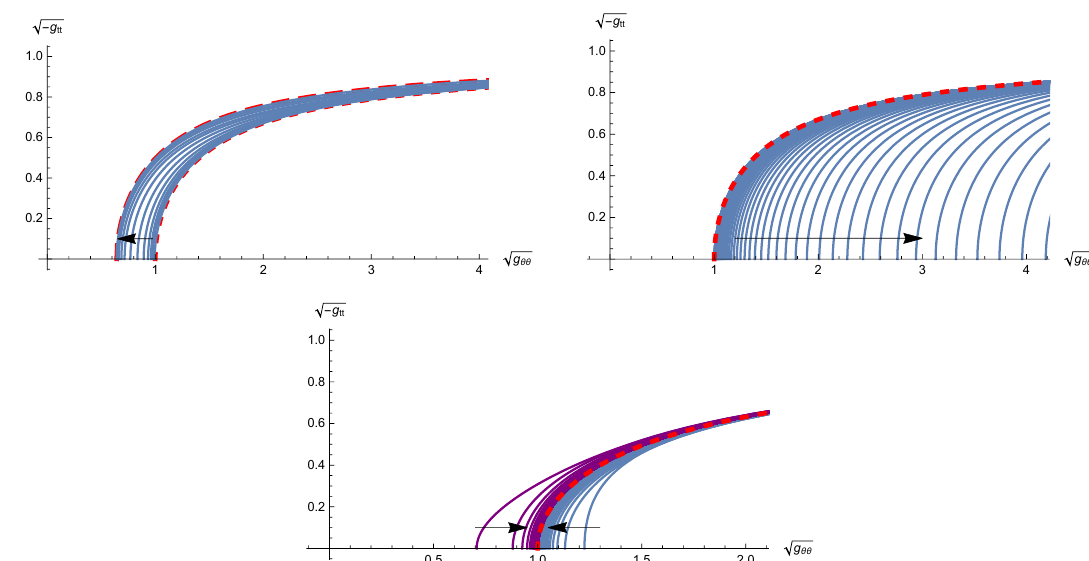
√ √ Figure 7 . Figure showing curves of − g tt against g θθ at constant intervals now for the magnetic EM flow. The top left and right hand frames are similar to those of the previous figure, being for an unstable magnetic RN solution with r − = 0 . 2 perturbed initially to have smaller horizon size (left) or larger horizon size (right). The latter gives the same expanding horizon behaviour as that of the uncharged or electric cases — here ∆ λ = 0 . 5 . The red dashed curve again shows the geometry of the initial RN fixed point that is perturbed. In the initially contracting case here a new stable magnetic RN solution exists for the same surface gravity and charge, and the flow asymptotes to this — here it has r + = 0 . 64 and we show the new stable fixed point geometry using longer red dashes. The flow curves in this case are plotted for λ = 0 , 10 , 12 , . . . , 22 , 24 , 30 , 50 and 1000 . The lower frame shows flows from a non-linear deformation of a fixed point with larger charge r + = 0 . 4 , so it is stable. Two flows are shown, one with larger horizon initially (blue curves) and one with smaller (purple curves). Both quickly return to the stable fixed point (shown by the red dashed curve) under the flow (for both curves are shown at intervals ∆ λ = 0 . 5 ). Arrows indicate the sense of change of the geometry under increasing flow